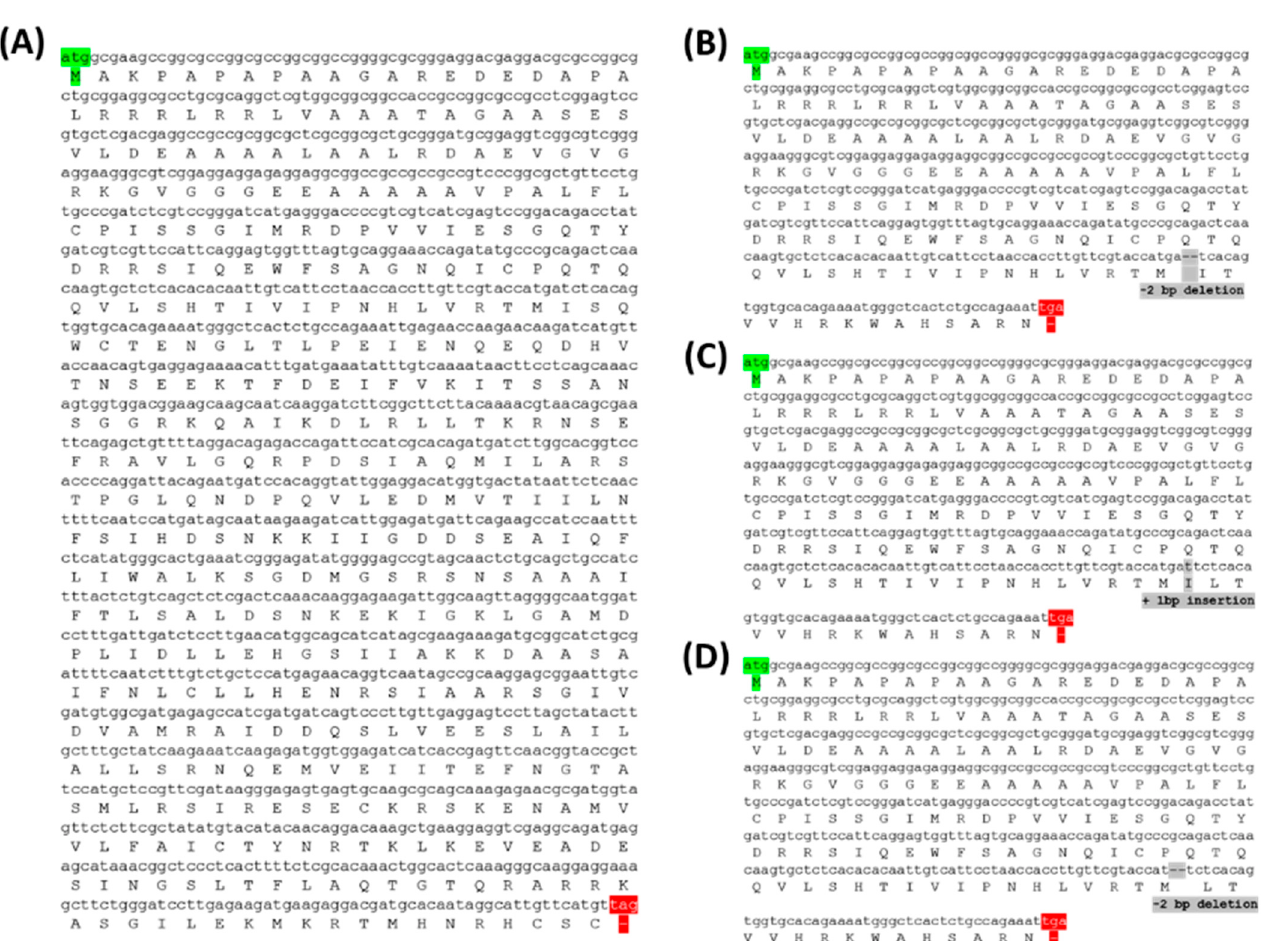
Figure 9. Identification of genotypes using NGS analysis in T 2 PUB7-GE. The minus ( − ) and plus (+) signs indicate the number of nucleotides deleted and inserted at the target sites, respectively. WT, wild type sequence with no mutations.